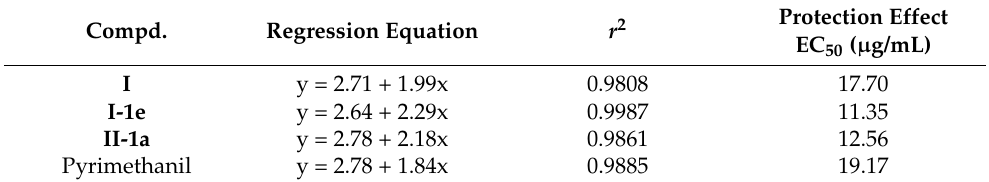
Table 2. EC 50 values of compounds I , I-1e , II-1a and pyrimethanil against Cercospora arachidicola Hori .